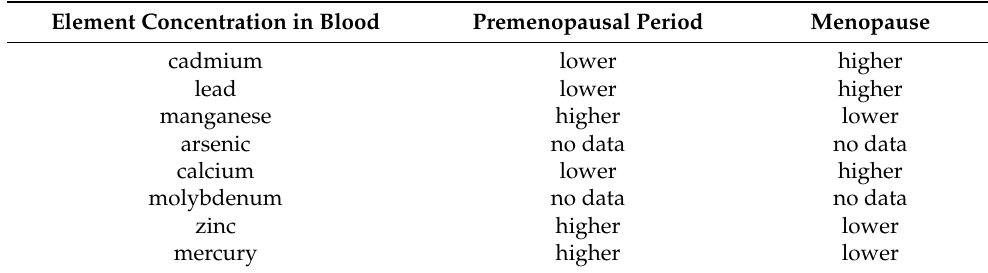
Table 1. Comparison of elemental concentrations in blood during premenopausal and menopausal periods. Based on